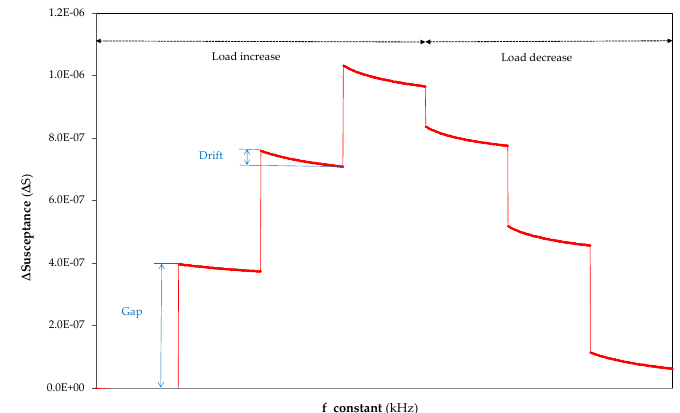
Figure 6. Diagram to introduce gap and drift concepts into the susceptance measurements in the time domain for the results interpretation ( Δ S at 1 kHz in an aluminium sample with a thickness of 3 mm).